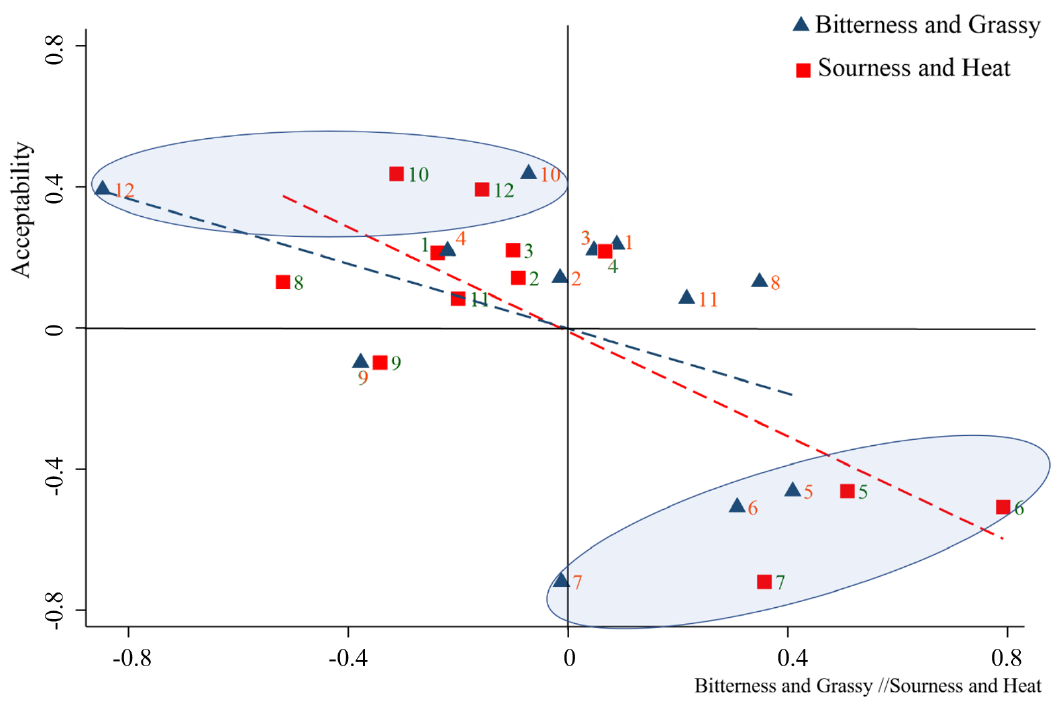
Figure 4. Estimated relations between the two main sensorial dimension of microgreens and the overall consumer acceptability. In this figure the x -axis represents scores of both latent factors representing the sensorial dimensions (Bitterness and Grassy; Sourness and Heat) while the y -axis represents the score on consumer’s acceptability. All latent constructs are standardized with a mean of 0 and a standard deviation of 1. 1. Komatsuna; 2. Tatsoi; 3. Pak choi; 4. Mizuna; 5. Mibuna; 6. Cress; 7. Amaranth; 8. Green basil; 9. Purple basil; 10. Coriander; 11. Purslane; 12. Swiss chard.